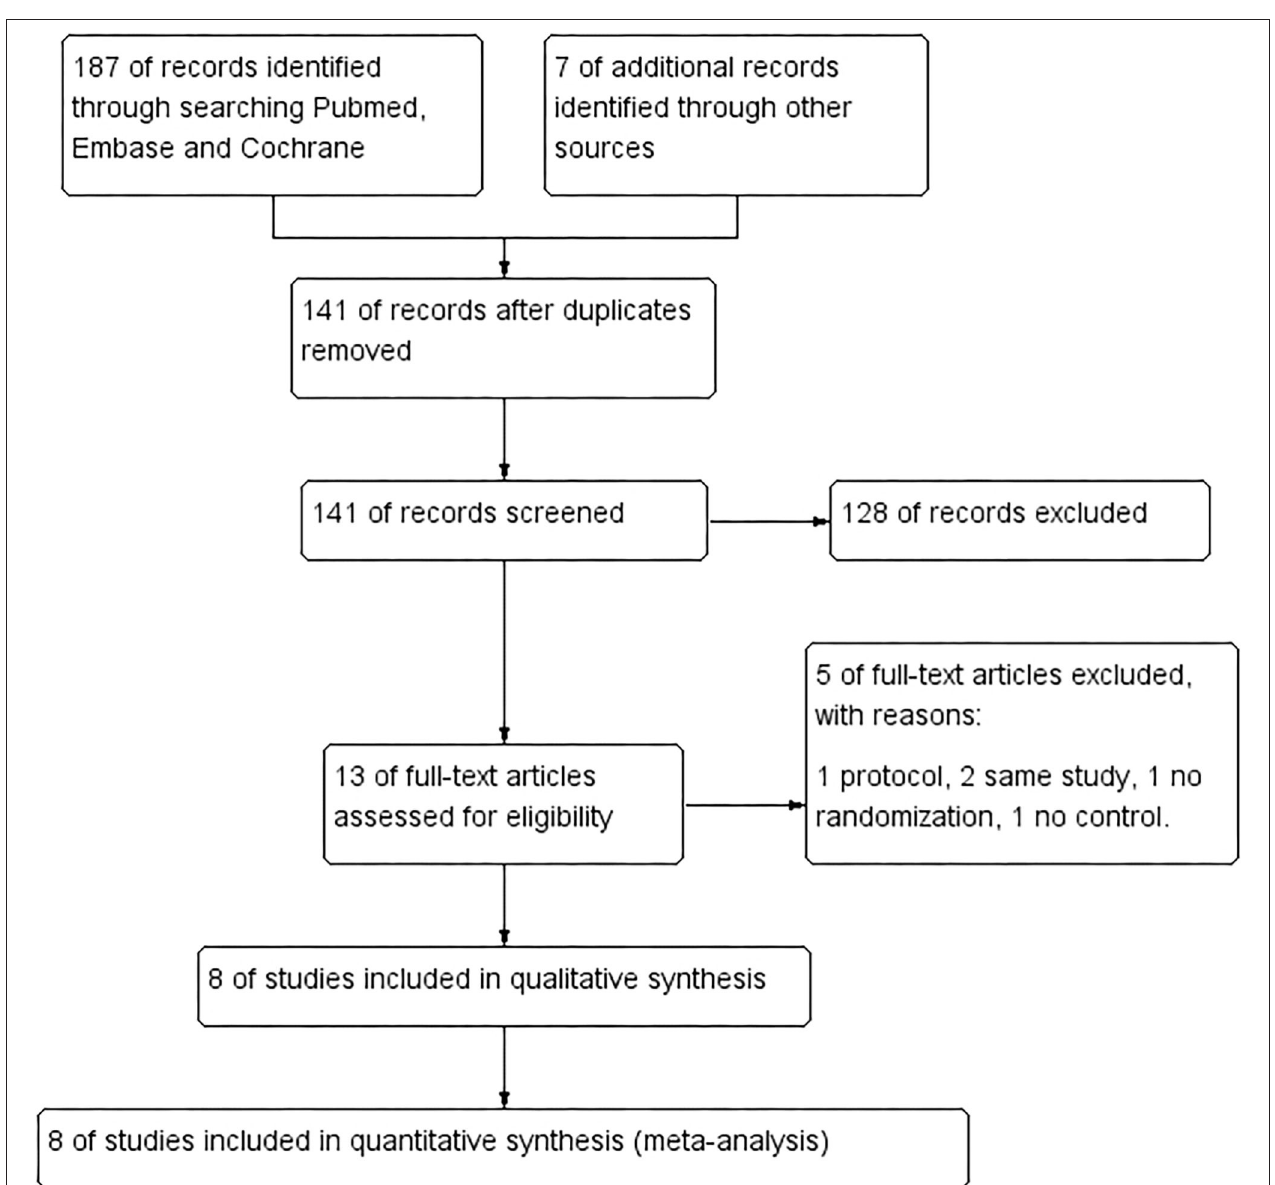
FIGURE 1 | Flowchart of study